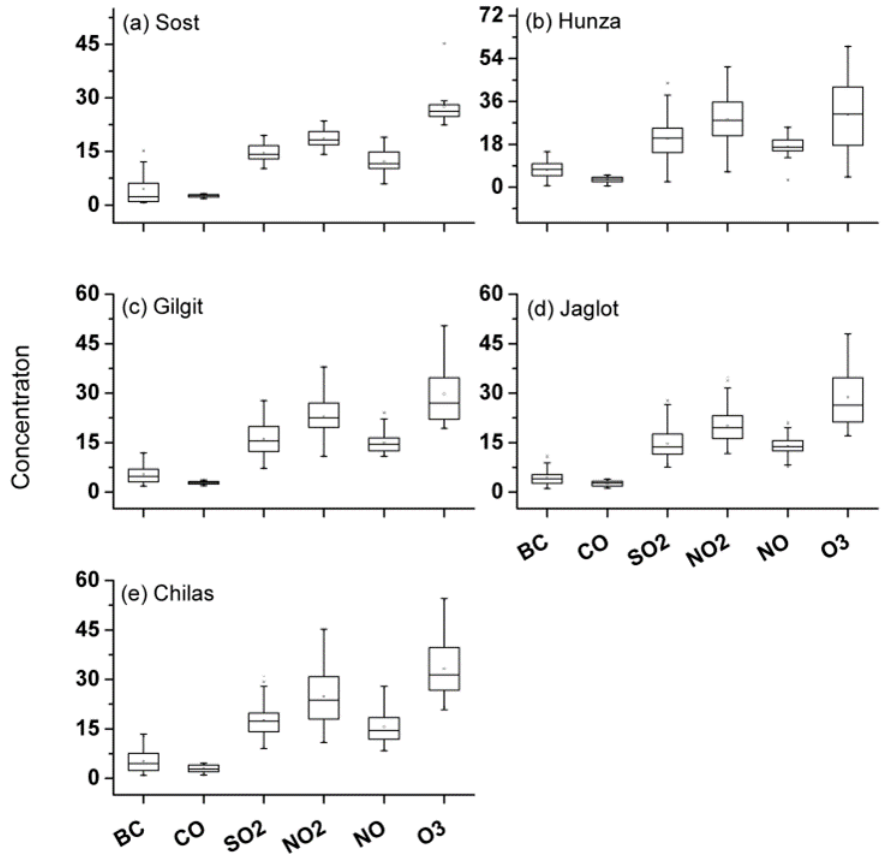
Figure 5. Variation in concentration ranges of BC ( µ g/m 3 ), CO (mg/m 3 ), SO 2 , NO, NO 2 and O 3 in µ g/m 3 at selected sites in Gilgit-Baltistan during summer, 2020.